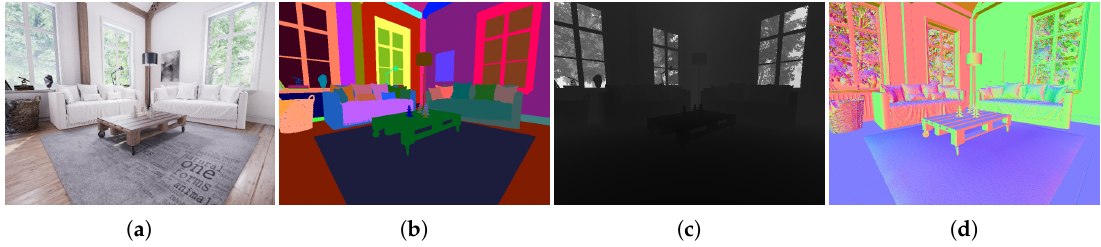
Figure 3. Capture options available in UnrealCV. ( a ): Lit RGB image; ( b ): Object mask; ( c ): Depth; ( d ): Surface